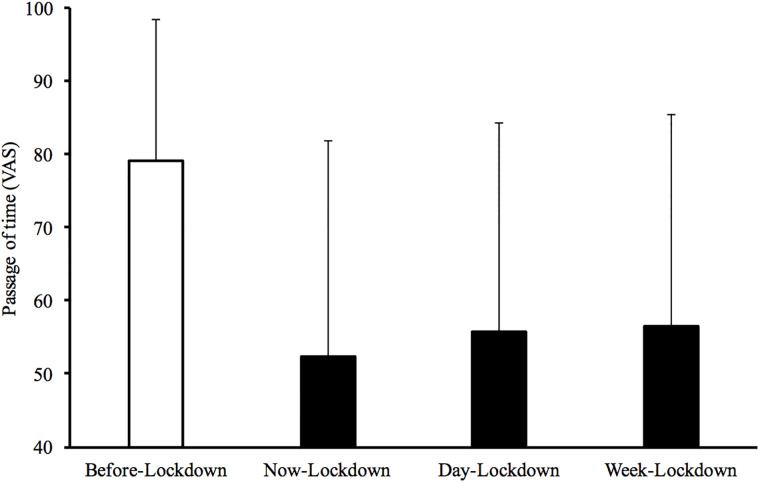
Mean passage of time for the period before the lockdown and during the lockdown, i.e., for the present, the day and the week.